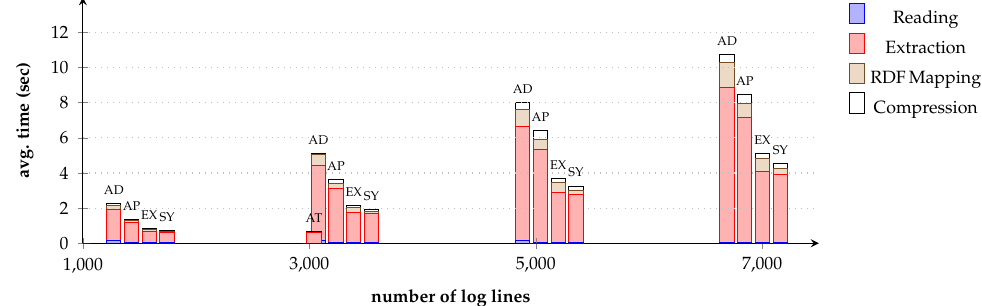
Figure 11. Average log graph generation time for n log lines with a single host (36 extracted properties) host in Figure 11. We used the data set from the first web server (i.e., mail.cup.com ) in this